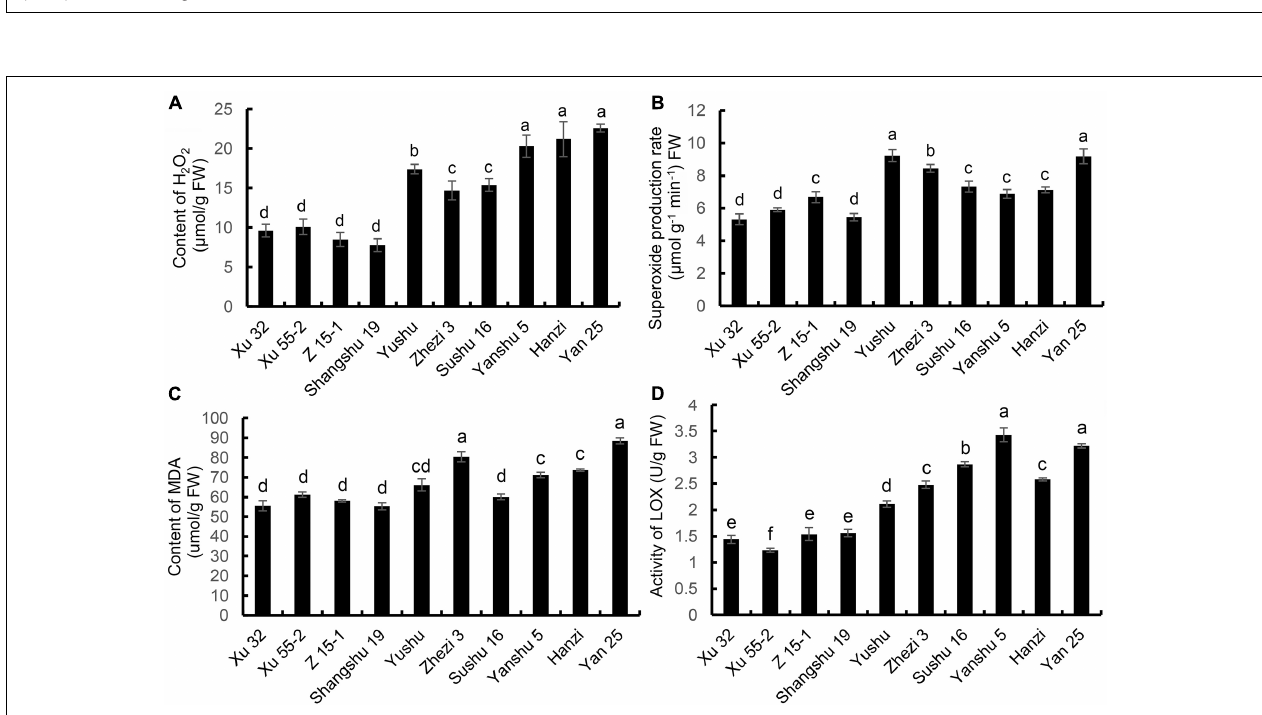
FIGURE 3 | (A) H 2 O 2 content, (B) O 2 · − production rate, (C) malondialdehyde (MDA) content, and (D) lipoxygenase (LOX) activity in the leaves of the 10 sweet potato cultivars. Data are presented as means ± SD ( n = 3). FW, fresh weight.